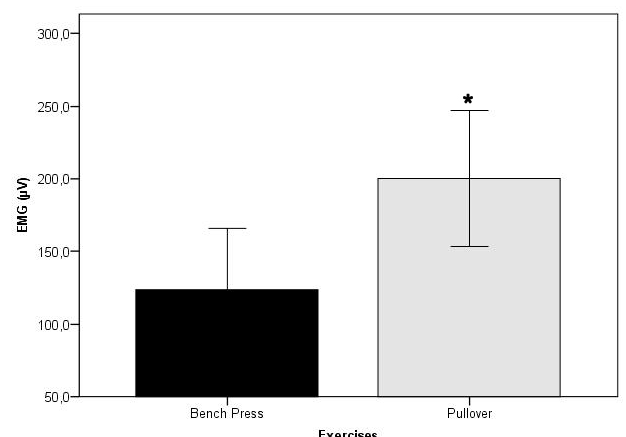
difference.Figure 3. Comparison of electromyographic activation of brachial tri- ceps long portion between horizontal bench press and barbell pullover exercises (mean and